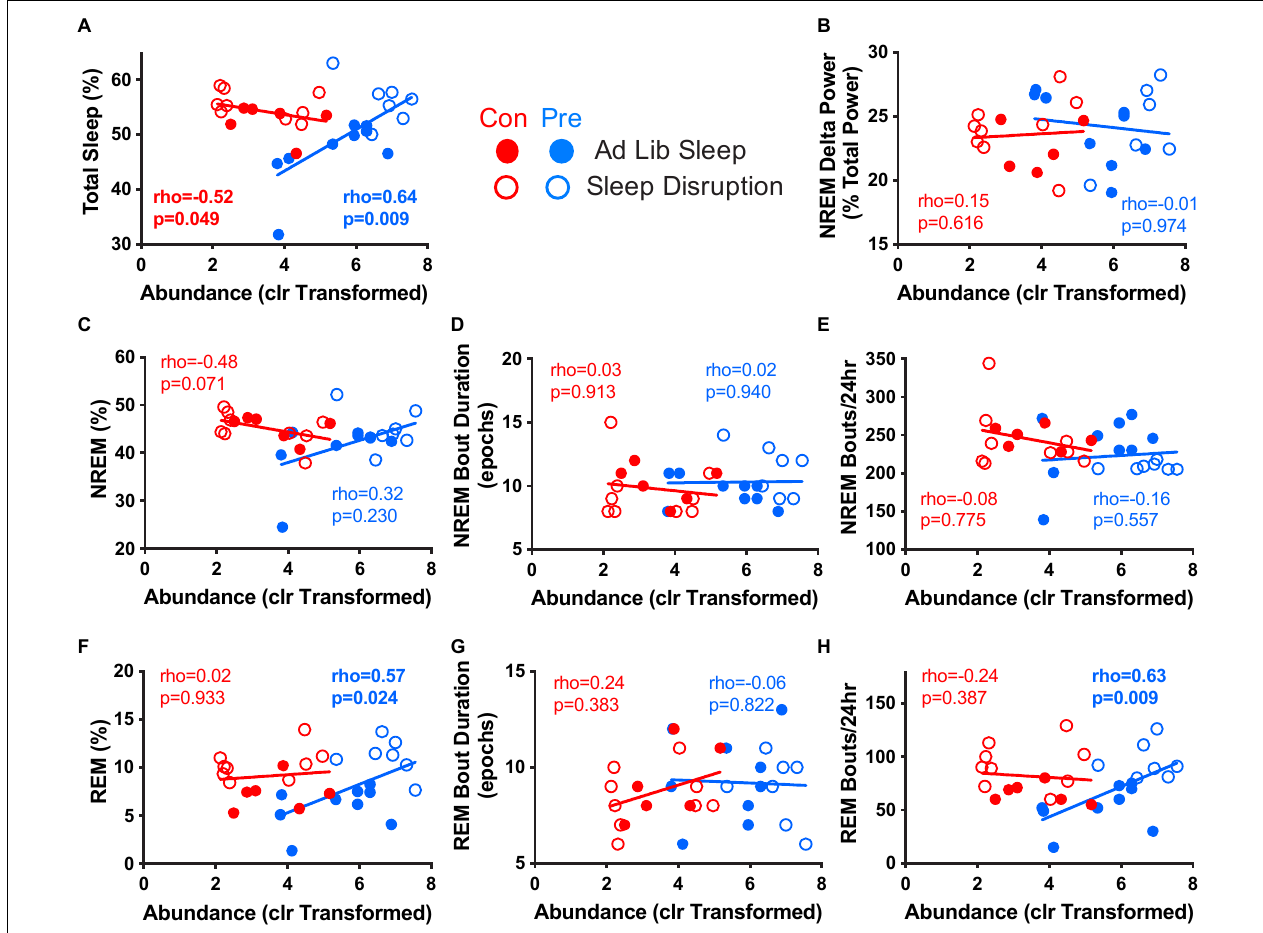
FIGURE 6 | Parabacteroides distasonis relative abundance is associated with multiple measures of post-sleep disruption recovery sleep. Spearman’s rank-based correlation analysis between the centered log ratio transformed abundance of P. distasonis at the end of the experiment (T4) and various measures of recovery sleep post-sleep disruption was performed within diet group for control (no sleep disruption, no social defeat) and sleep disruption only groups. Results for (A) total sleep, (B) NREM delta power, (C) NREM percent, (D) median NREM bout duration, (E) NREM bouts per 24 h, (F) REM percent, (G) , median REM bout duration, and (H) REM bouts per 24 h are depicted above. Con, control diet; clr, centered log ratio; Pre, prebiotic diet; NREM, non-rapid-eye movement sleep, REM, rapid-eye movement sleep. n =